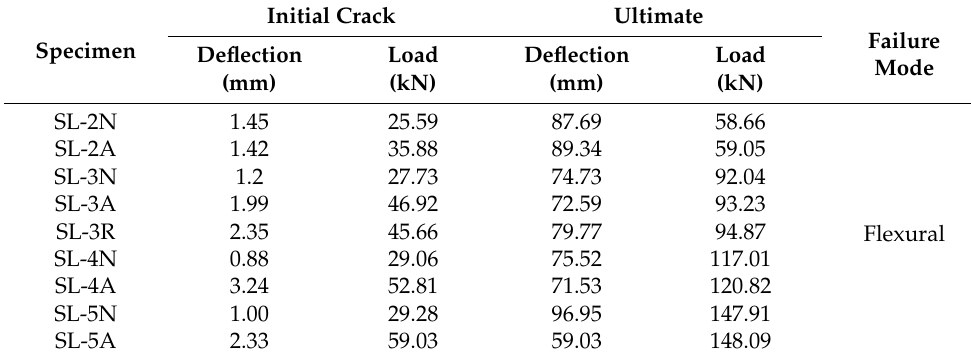
Table 3. Summary of test